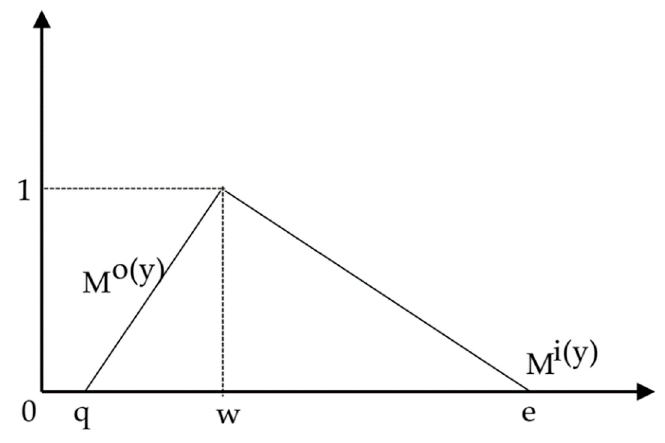
Figure 4. Triangular Fuzzy Number.